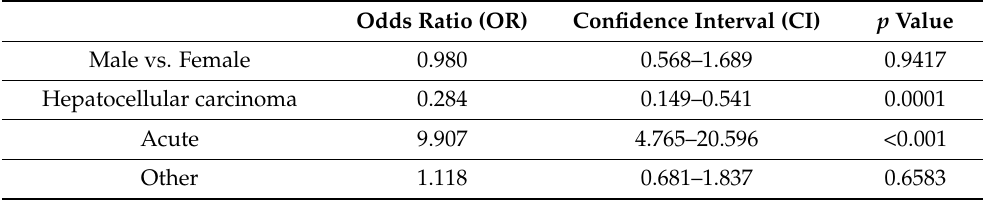
Table 3. Odds ratios, confidence intervals and p -values for predictive variables are shown. BMI: Body mass index; OLT: orthotopic liver transplantation; MDRD: Modification of Diet in Renal Disease; PRBC: packed red blood cells. Odds Ratio (OR) Confidence Interval (CI) p Value Male vs. Female 0.980 0.568–1.689